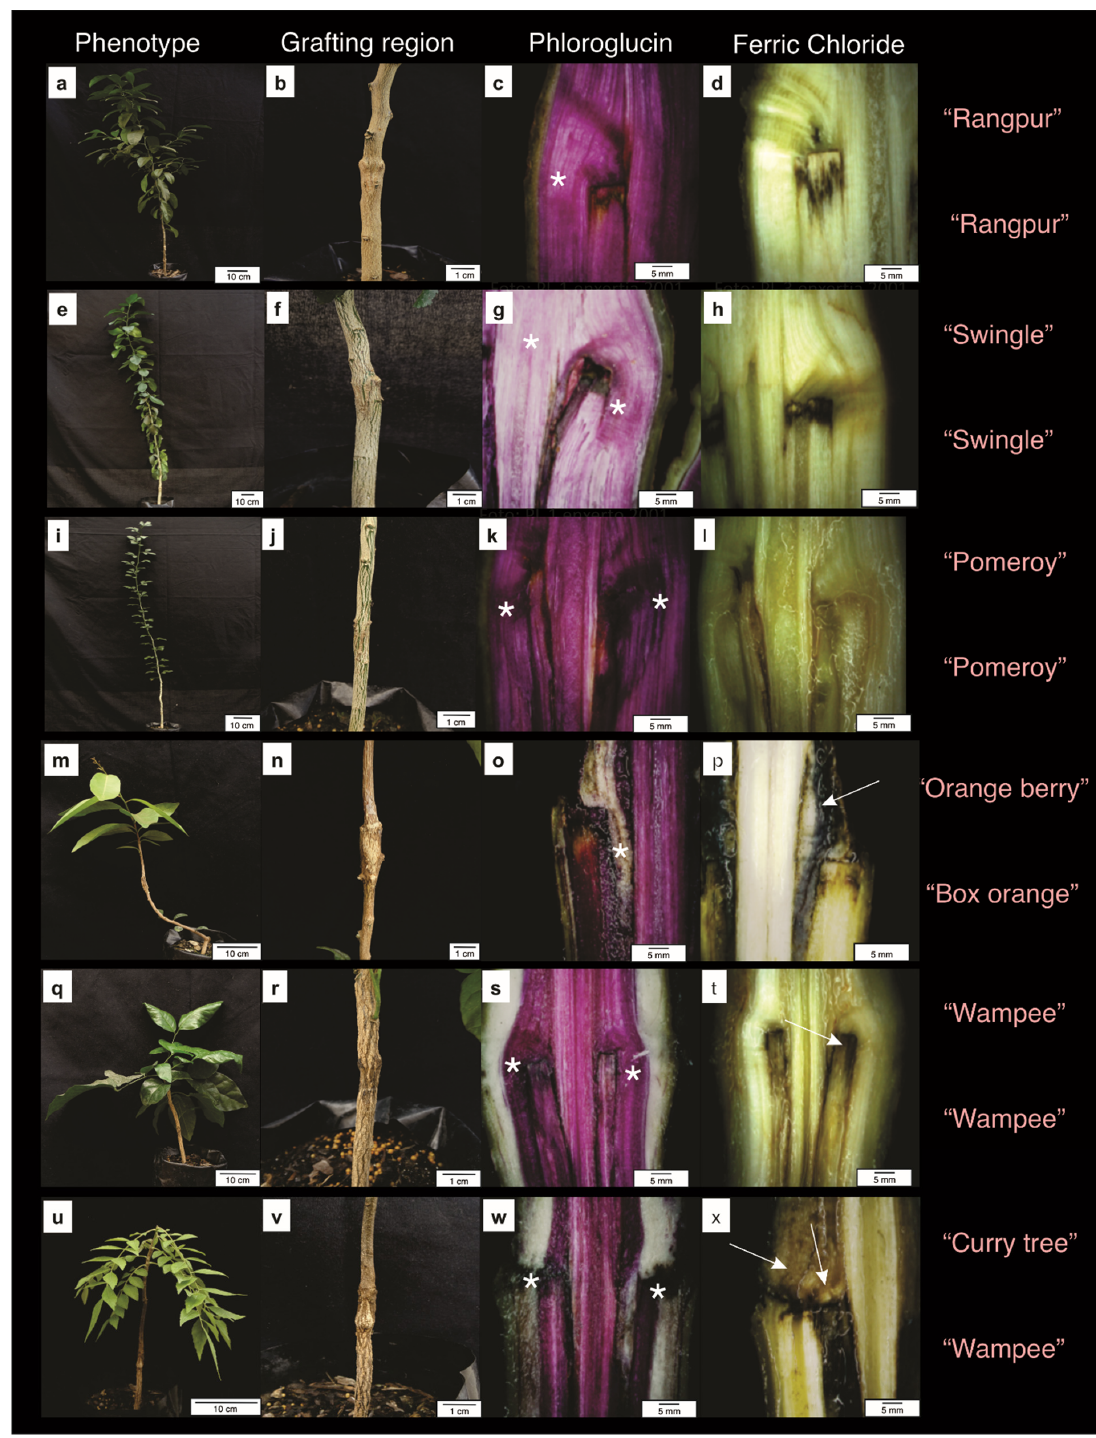
Figure 2. Six grafting combinations of Aurantioideae plants indicating the plant phenotype ( a , e , i , m , q , u ), and images of the graft union ( b , f , j , n , r , v ), phloroglucin reaction ( c , g , k , o , s , w ), and ferric chloride ( d , h , l , p , t , x ). Asterisks in ( c , g , k , o , s , w ): pink indicates lignified cell walls. Arrows in ( p , t , x ): ferric chloride indicates phenolic compounds in brown. Rangpur/Rangpur, Swingle/Swingle, Wampee/Wampee, and Pomeroy/Pomeroy have great vascular connection ( c , g , k , s ) and do not present phenolic compounds ( d , h , l , t ). Orange berry/Box orange and Curry tree/Wampee present a poor vascular connection and phenolic compounds at the graft region.